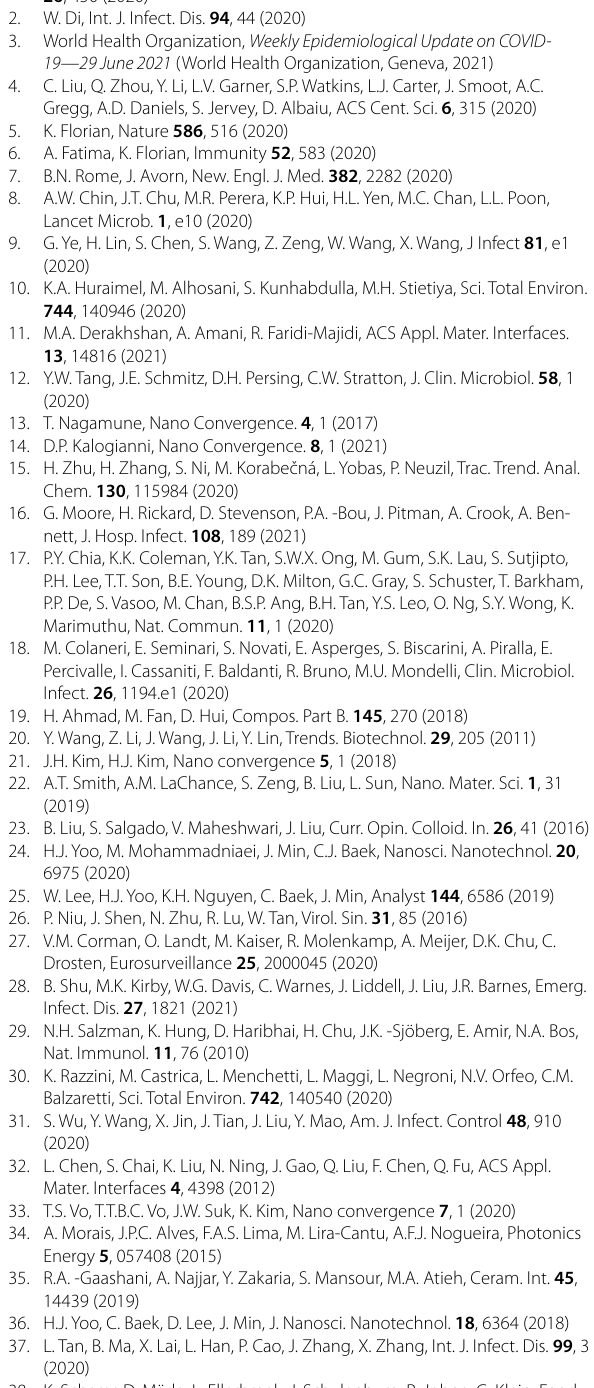
Additional file 1: Table S1. PCR primer set of each RNA and DNA. Figure S1. SARS‑ CoV‑2 RNA stability in environmental surface condition.